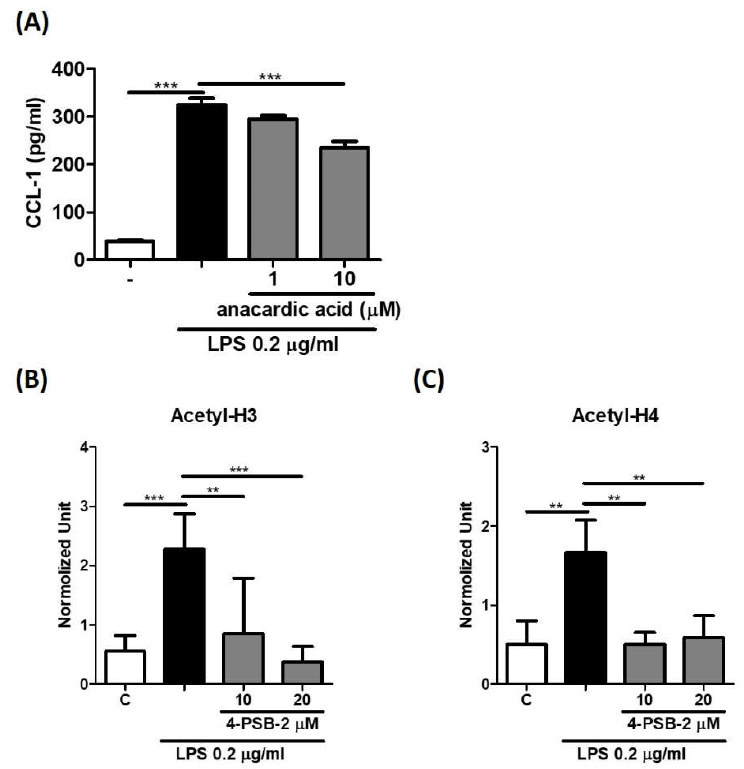
Figure 5. 4-PSB-2 significantly downregulated LPS-induced CCL1 expression in THP-1 cells via histone acetylation. After pretreatment with medium alone ( C ) or AA for 1 h followed by LPS stimulation for 24 h, the CCL-1 production ( A ) was measurement by ELISA. After pretreatment with medium alone ( C ) or 4-PSB-2 for 2 h followed by LPS stimulation for 0.5 h, the acetylation of histone H3 ( B ) and histone H4 ( C ) at the promoter regions of CCL1 gene were assessed by ChIP. Data present the means ± SD of 3 independent experiments. (* p < 0.05, ** p < 0.01, and *** p < 0.001.)